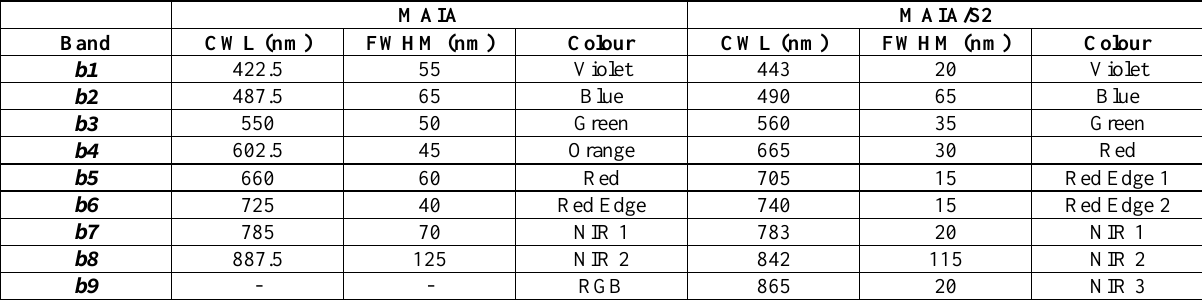
Table 1. Optical bands of the two MAIA camera models, characterised by the central wavelength (CWL) and the full width at half maximum (FWHM).